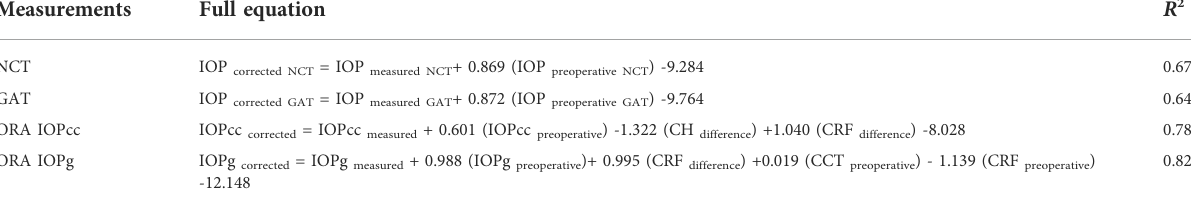
TABLE 3 Predictive equations for corrected intraocular pressure after